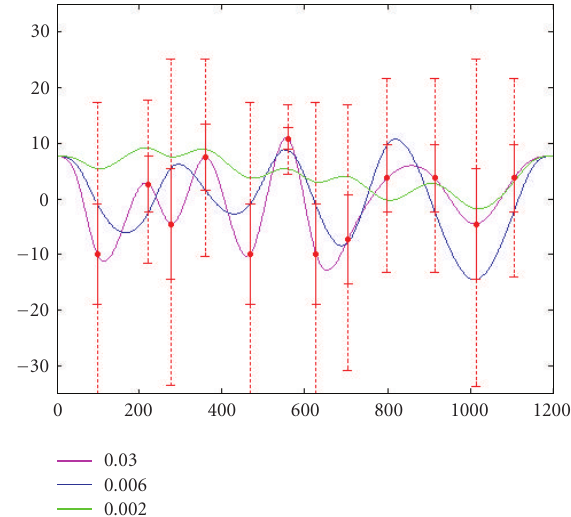
Figure 7: The spline curves for the results shown in Figures 6(a) (pink), 6(b) (blue), and 6(c) (green). The horizontal axis gives time for the speech utterance. The key shows the value of the global accel- eration constraint. The red circles are the targets. The solid vertical red bars show the range constraints for Figures 6(a) and 6(b). The dotted bar is the relaxed range constraint for Figure 6(c).